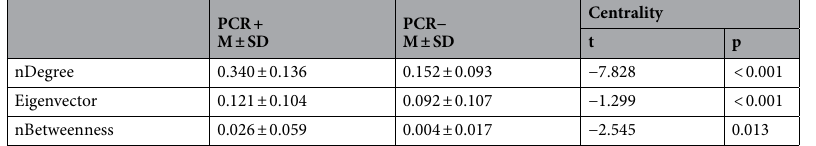
Table 3. Independent-samples t-test of centrality measures (nDegree, eigenvector and nBetweenness) by PCR + and PCR-.